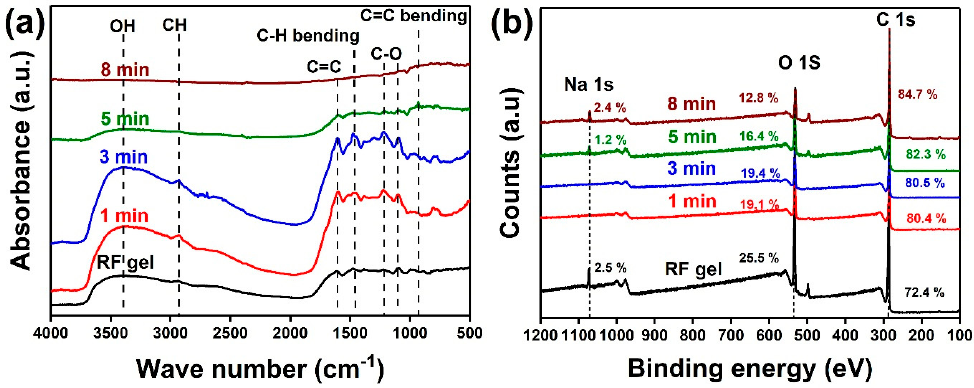
Figure 4. ( a ) FTIR spectra and ( b ) XPS survey spectra of OCNs obtained after the time-dependent plasma surface treatment on RF gel at a power:250 W, and flow rate:100:50 sccm.